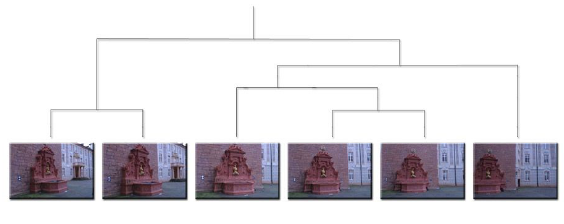
Figure 1: An example of dendrogram for a 6 views